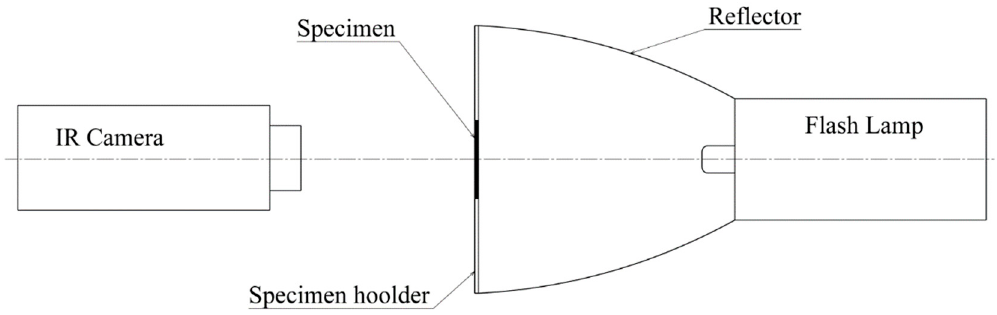
Figure 4. Thermal diffusivity and specific heat capacity measurement configuration.